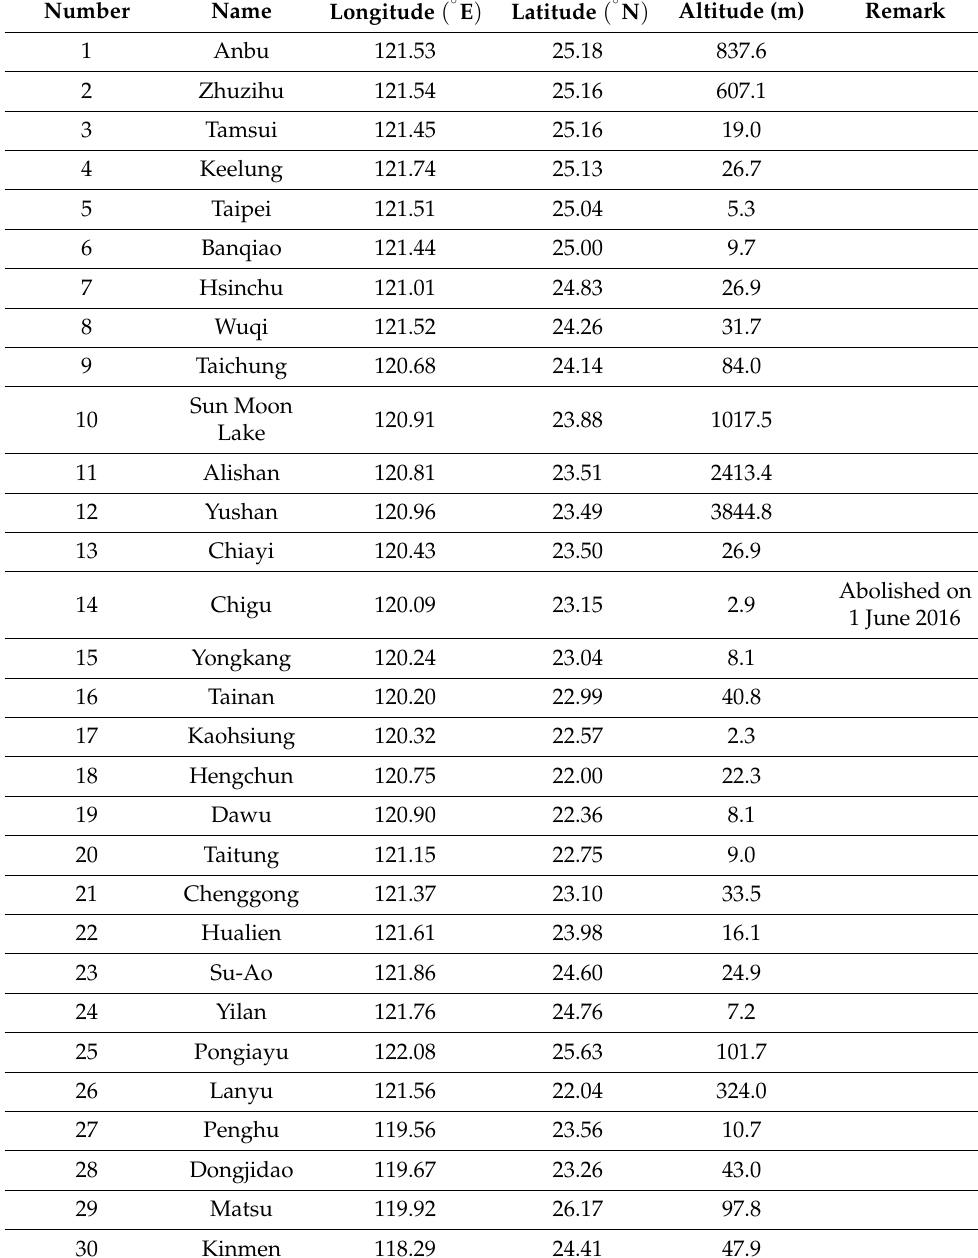
Table 1. Weather stations for this